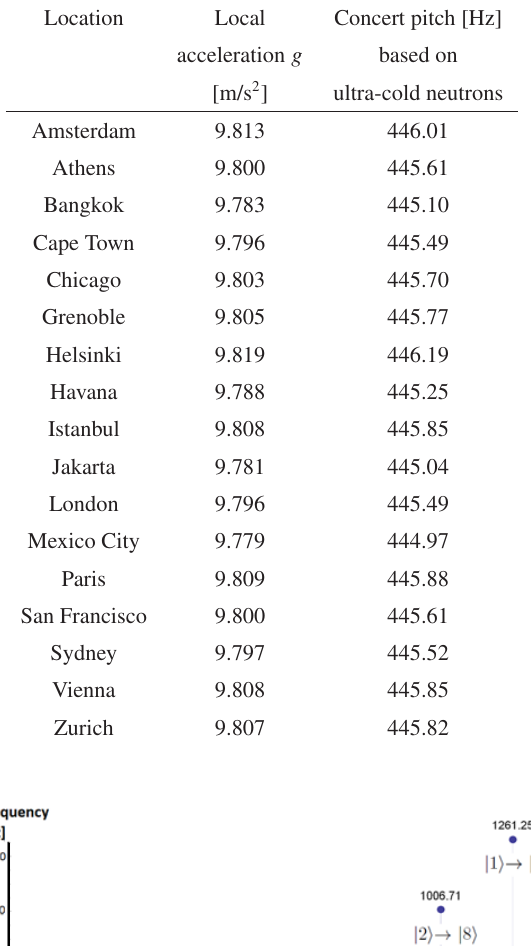
Table 2. A selection of cities with corresponding local acceleration g . Each city has its own character. To take this fact into account it is suggested to establish a local concert pitch for music performances based on local g and on ultra-cold neutrons.